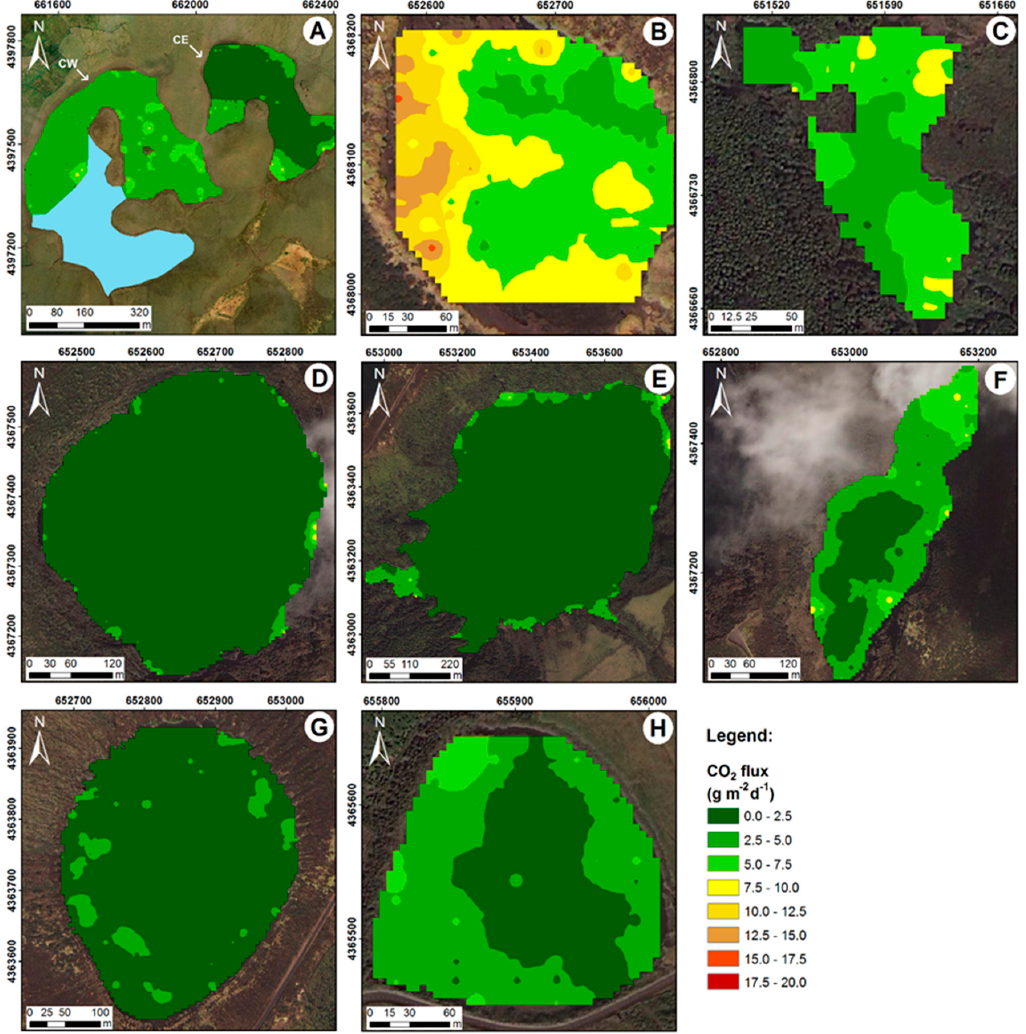
Figure 6. E-type CO 2 flux maps for the Corvo ( A ) and Flores lakes: ( B ) Branca; ( C ) Patos; ( D ) Negra; ( E ) Funda; ( F ) Comprida; ( G ) Rasa; and ( H ) Lomba lakes in first survey (UTM–WGS84, zone 25S; interpolation method—sequential Gaussian simulation (sGs)).